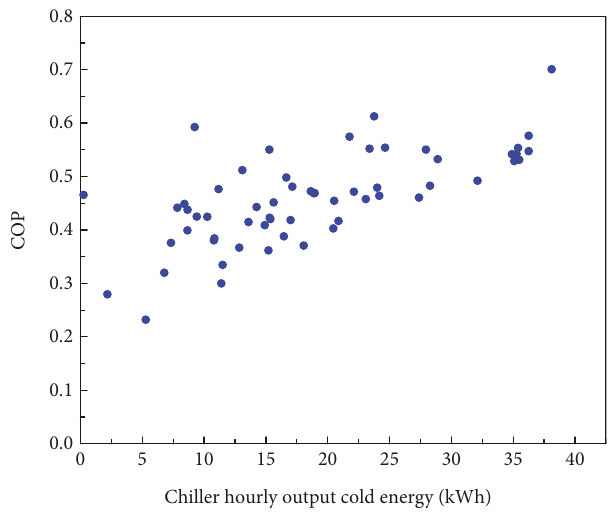
Figure 7: Dependence of the chiller daily average COP on the cold energy demand from 08 July 2015 to 14 July